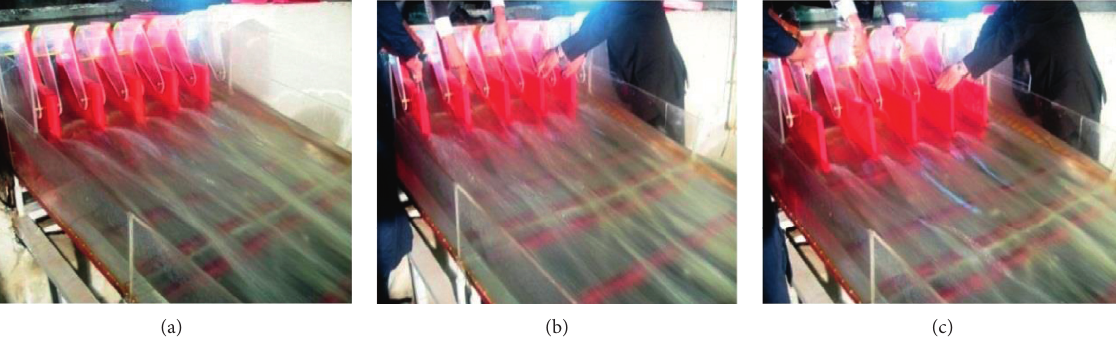
Figure 12: The shockwaves jump for different options at 5000 cubic meters per second: (a) initial plan, (b) first option, and (c) third option- final one.